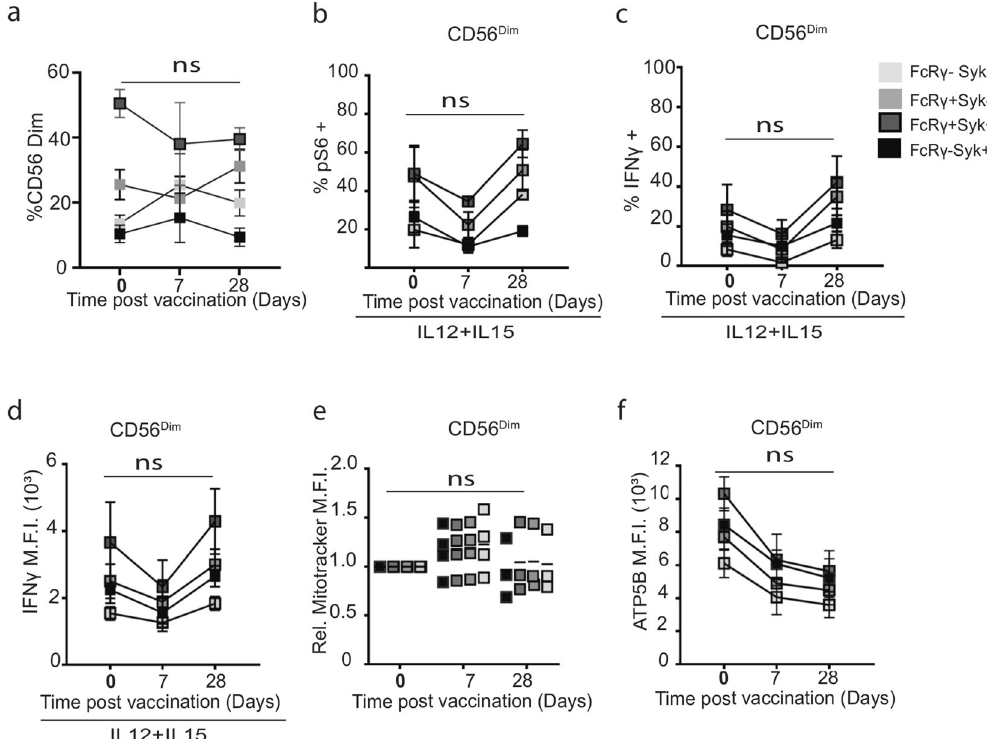
Fig. 4 HCMV impacts on functional and metabolic responses of CD56 dim NK cell subsets post vaccination. Summary of canonical and adaptive CD56 dim NK cells responses at baseline and post-priming vaccination (Day 0, Day 7 and Day 28). Canonical (Fc ε R γ 1 + Syk + ) or adaptive (Fc ε R γ 1 + Syk − , Fc ε R γ 1 − Syk + and Fc ε R γ 1 − Syk − ) cells were analysed as indicated for a ex vivo frequencies of NK subsets, b frequency of pS6 + , c IFN γ + and d IFN γ MFI in response to IL-12/IL-15 stimulation after vaccination ( n = 4). e Summary of post-priming Mitotracker and f ATP5B MFI in canonical and adaptive CD56 dim NK cells at baseline and Days 7 and 28 ( n = 4). Error bars show SEM. a , e , f Samples were compared by mixed-model with Bonferroni post hoc test. b – d Samples were compared by two-way ANOVA with Sidek ’ s post hoc test. n.s. not signi fi